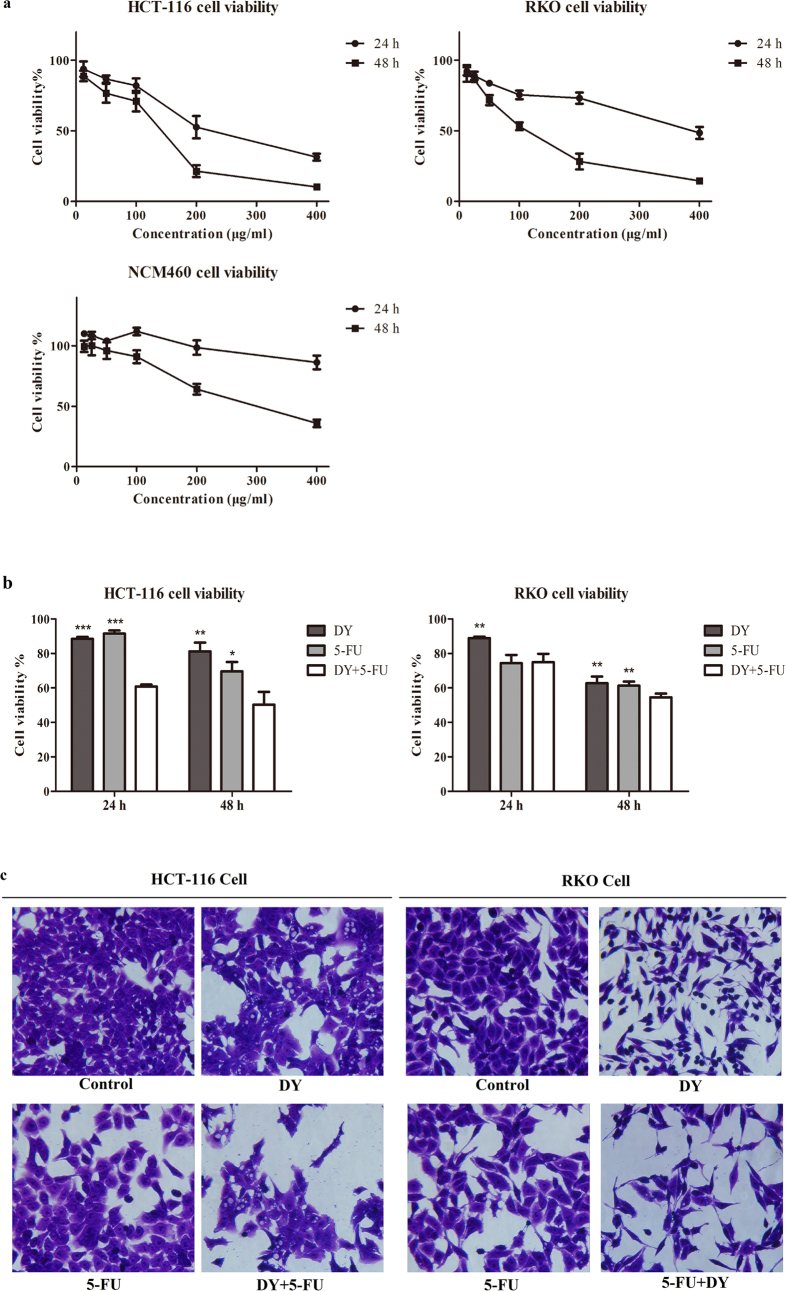
DY exhibited anti-proliferation effects against CRC cells and sensitized them to the cytotoxicity of 5-FU.(a) Cells were treated with DY extracts (12.5–400 μg/ml) for 24 or 48 h, CCK8 assay was then performed to evaluate the cell viability. (b) Cells were separately incubated with DY (100 μg/ml) or 5-FU (20 μM, HCT-116; 5 μM, RKO) and their combination for 24 or 48 h and cell viabilities were assessed by CCK8 assay. *P < 0.05, **P < 0.01, ***P < 0.001, compared with (DY + 5-FU) group. Results are expressed as mean ± SD (n = 3). (c) Cellular morphologies of CRC cells with 48 h treatments as described in (b) were observed under inverted microscope (400×).